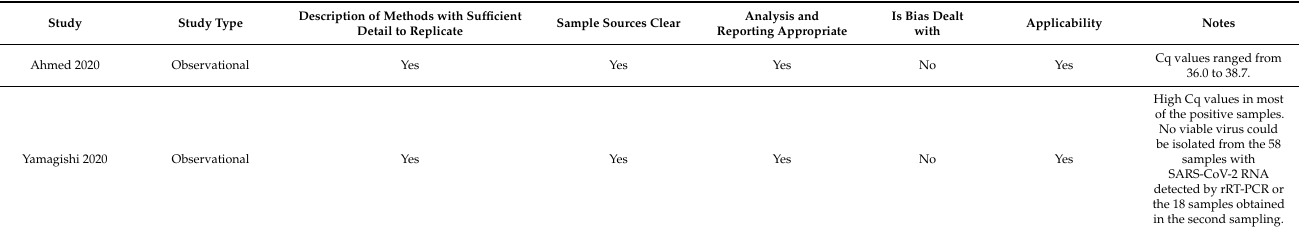
Table 3. Quality assessment of included environmental studies.